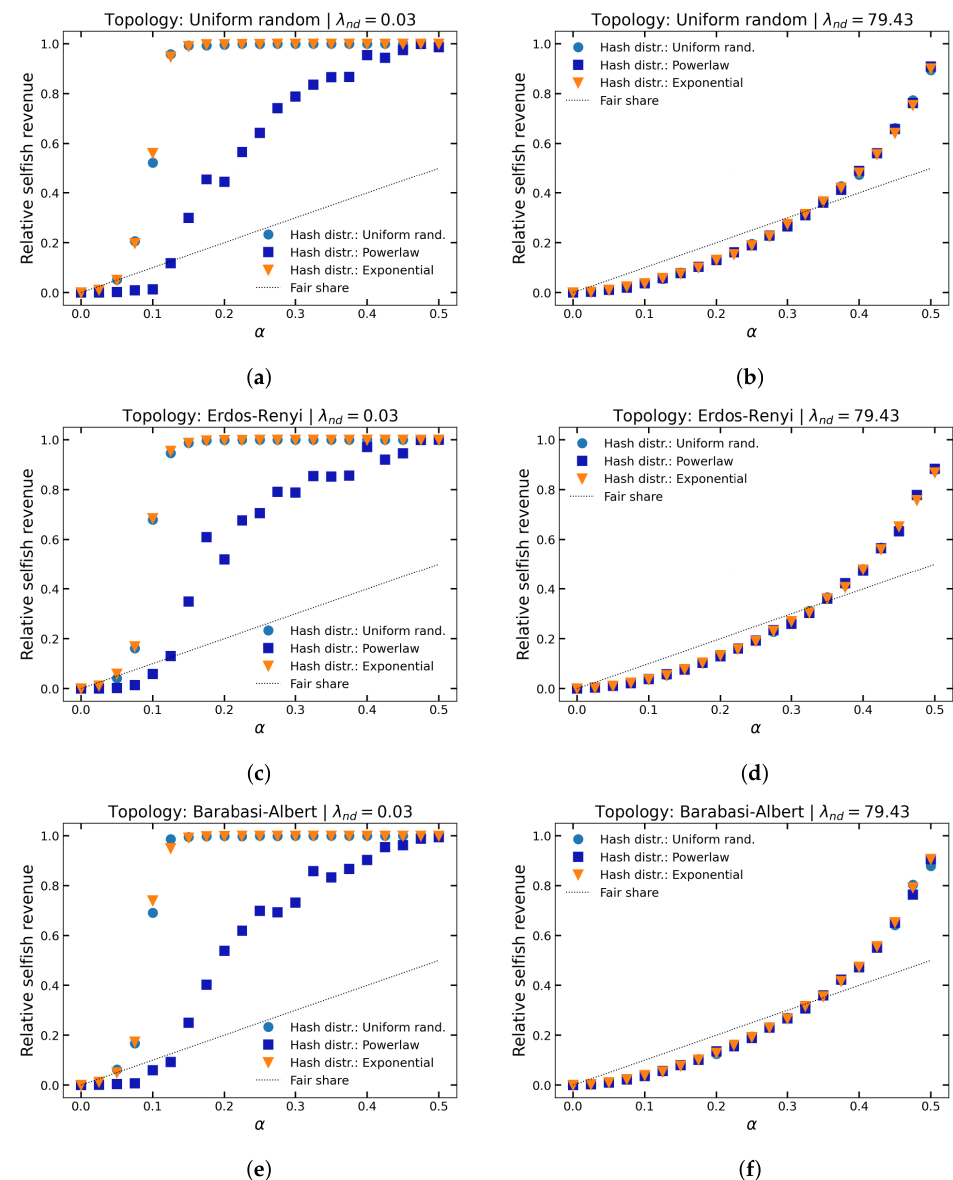
Figure 4. Relative selfish revenue as a function of selfish hashing power ( α ) for different network topologies: in ( a , b ) the network is in the uniform random topologies; in ( c , d ) the network is in the Erdos-Renyi topologies; and in ( e , f ) the network is in the Barabasi-Alber topologies. In addition, the subfigures in left column show the results when network has very high latency λ nd = 0.03, and those in right column show the results with low network latency λ nd =